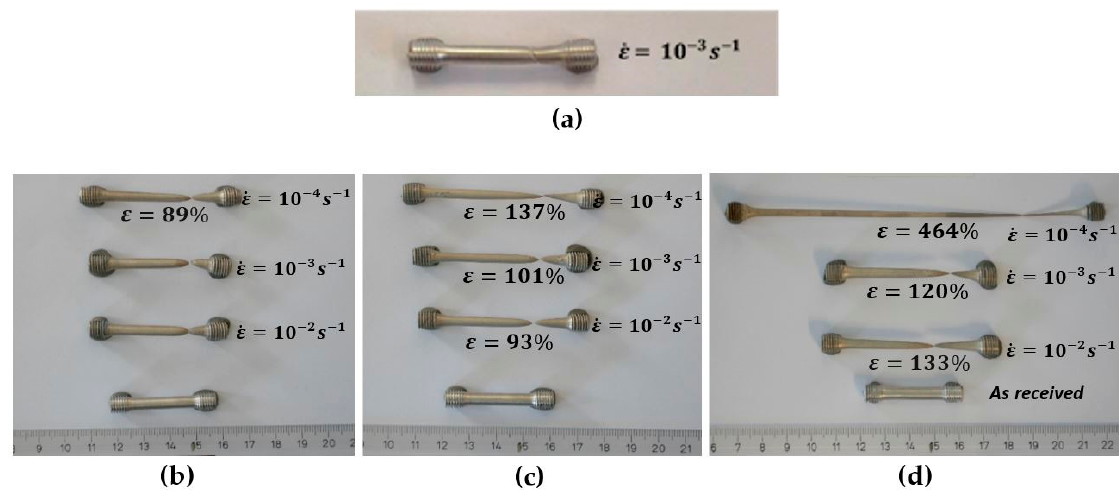
Figure 8. Appearance of tensile specimens after deformation to failure at ( a ) room temperature and at ( b ) 150, ( c ) 200, and ( d ) 250 °C under various strain rates.